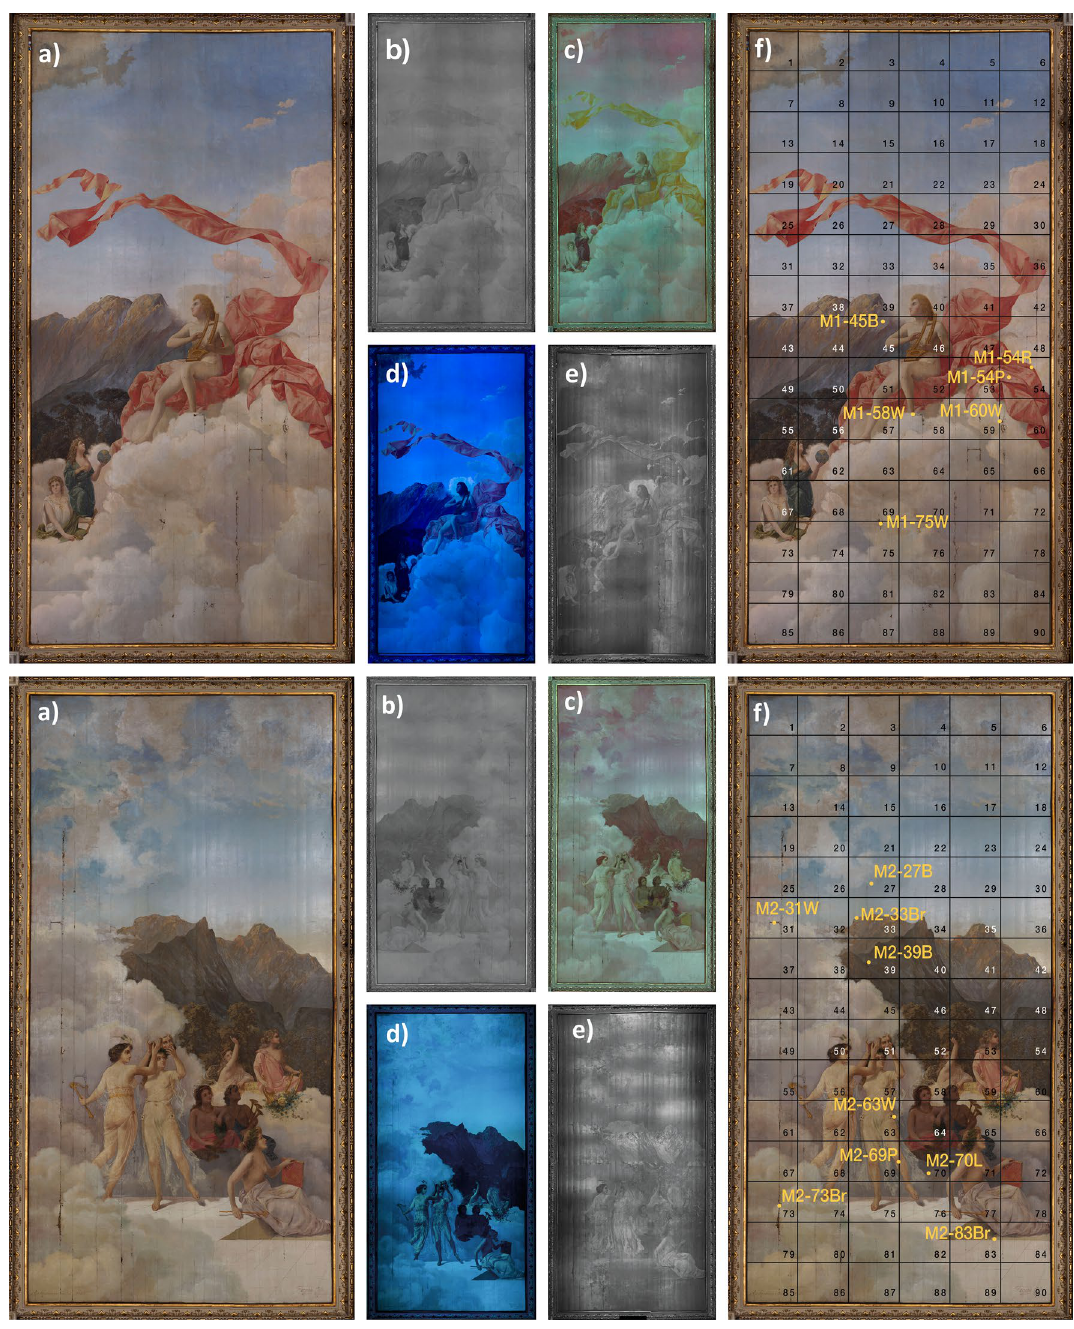
Figure 2. Six views at once: multispectral imaging of Musas I (top panel) and Musas II (bottom panel), ( a ) Visible (VIS), ( b ) infrared (IR), ( c ) infrared false colour (IRFC), ( d ) ultraviolet fluorescence (UVF) and ( e ) ultraviolet reflectance (UVR) multispectral images of Musas I and Musas II and ( f ) sample locations on the grid. The M1-XXY codification of sample names indicates: M1 = Painting Musas I , M2 = Painting Musas II , XX = location on the grid, Y = visible colour of the sample (B = blue, R = red, P = pink, W = Musas I and Musas II , respectively. Five spectral regions are shown: visible (VIS) in Fig. 2a (top) and Fig. 2a (bot- tom), infrared (IR) in Fig. 2b (top) and Fig. 2b (bottom), infrared false colour (IRFC) in Fig. 2c (top) and Fig. 2c (bottom), ultraviolet fluorescence (UVF) in Fig. 2d (top) and Fig. 2d (bottom), and ultraviolet reflected (UVR) in Fig. 2e (top) and Fig. 2e (bottom). VIS images show that Musas I and Musas II are complex systems of detailed artistry, including myriad colours, glazes, textures and brushstrokes, some of which may be a product of restora- tion efforts. The materials interact with one another and with environmental factors over time, as the paintings have been mounted on a wooden ceiling for more than 120 years. We can observe some damage in Fig. 2a (top) and Fig. 2a (bottom). Infrared images in Fig. 2b (top) and Fig. 2b (bottom) show inner layers of the paintings, because some external layers do not absorb infrared radiation, rendering them transparent 1 . Other materials